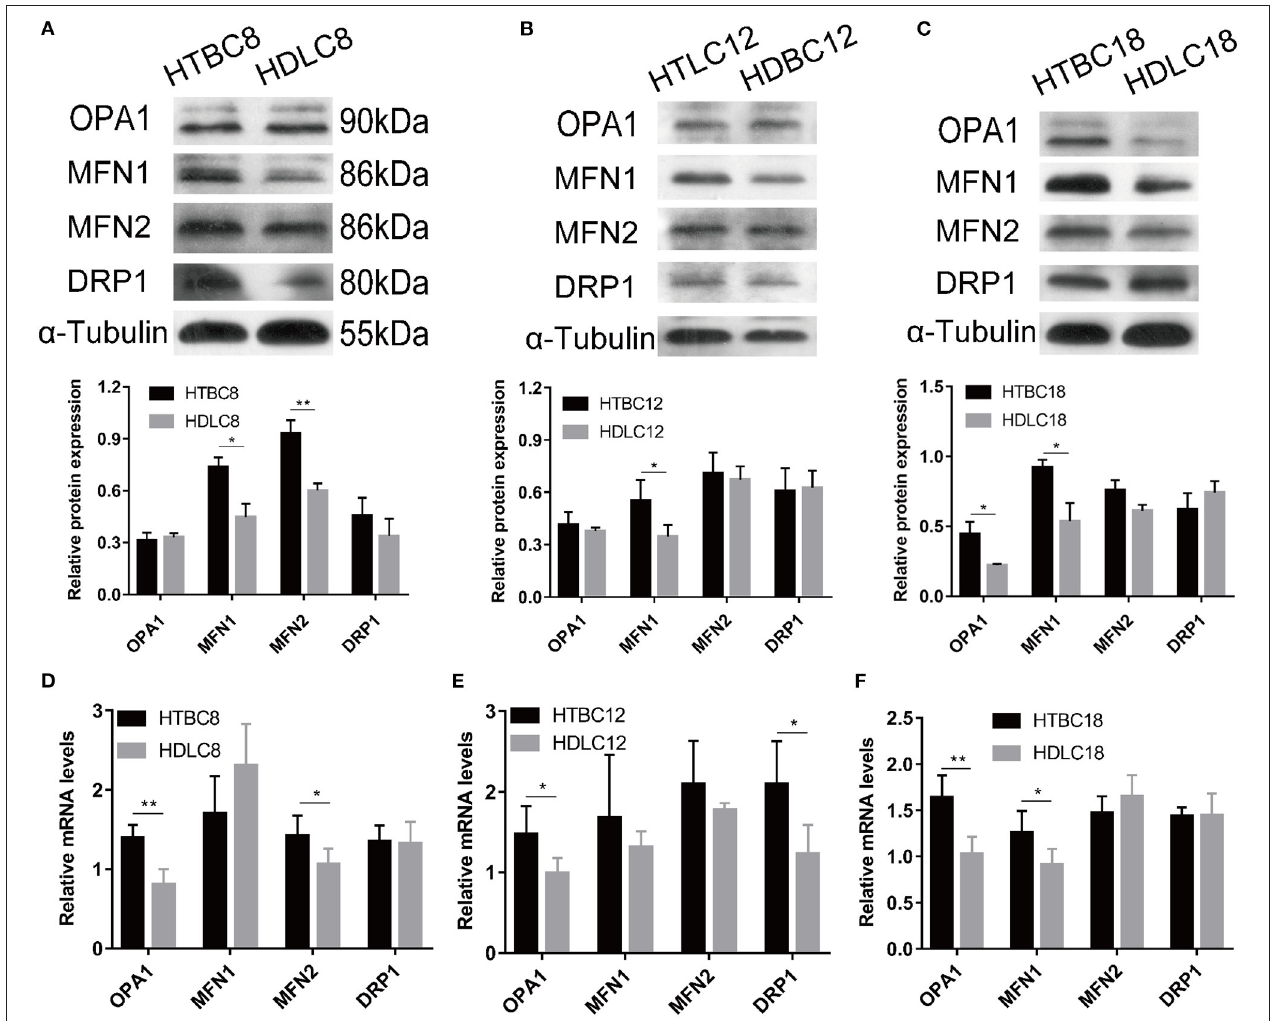
FIGURE 8 | The mRNA expression and Western blot results under hypoxia at different developmental stages of chicken. (A–C) The Western blot on days 8, 12, and 18 of incubation under hypoxia ( n = 3). (D–F) The mRNA expression on days 8, 12, and 18 of incubation under hypoxia ( n = 6). HTBC, TBCs under hypoxia; HDLC, DLCs under hypoxia. Data are indicated as the mean ± SEM. Asterisks represent significance TBCs compared to DLCs. * P < 0.05, ** P <